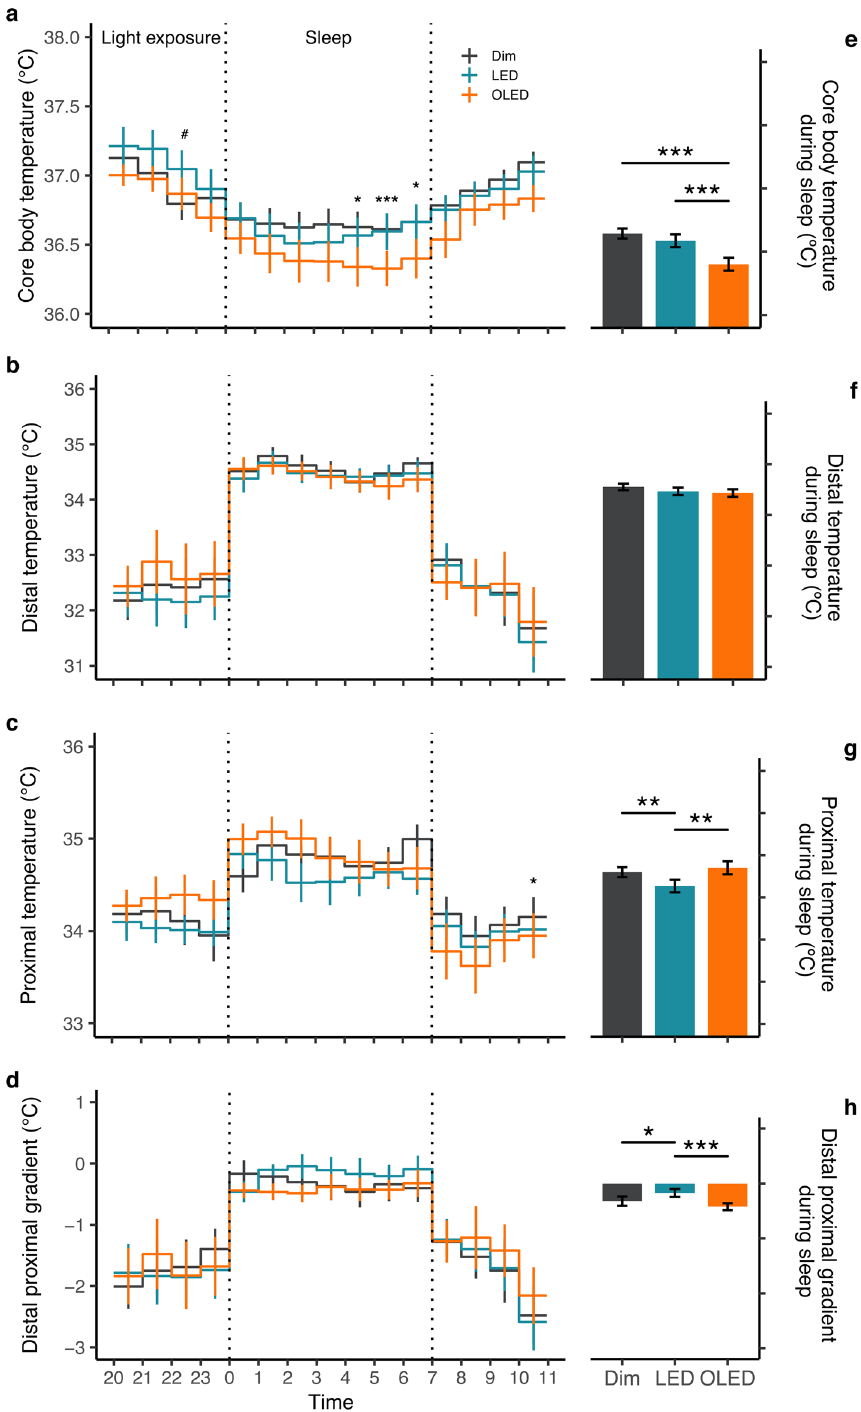
Figure 2. Thermoregulatory measures. Time course (left panel) and mean values during sleep (right panel) are illustrated. ( a ) Core body temperature, ( b ) distal temperature, ( c ) proximal temperature, and ( d ) distal proximal gradient expressed as mean ± SE. Time course analysis from two-way repeated measures ANOVA, post-hoc pairwise comparison with Bonferroni’s adjustment; * p < 0.05, *** p < 0.001 between OLED and dim light, # p < 0.05 between LED and dim light. Mean temperature during sleep by light condition from one-way repeated measures ANOVA, post-hoc pairwise comparison with Bonferroni’s adjustment; * p < 0.05, ** p < 0.01, *** p < 0.001. ( n = 10 core body temperature; n = 8 skin